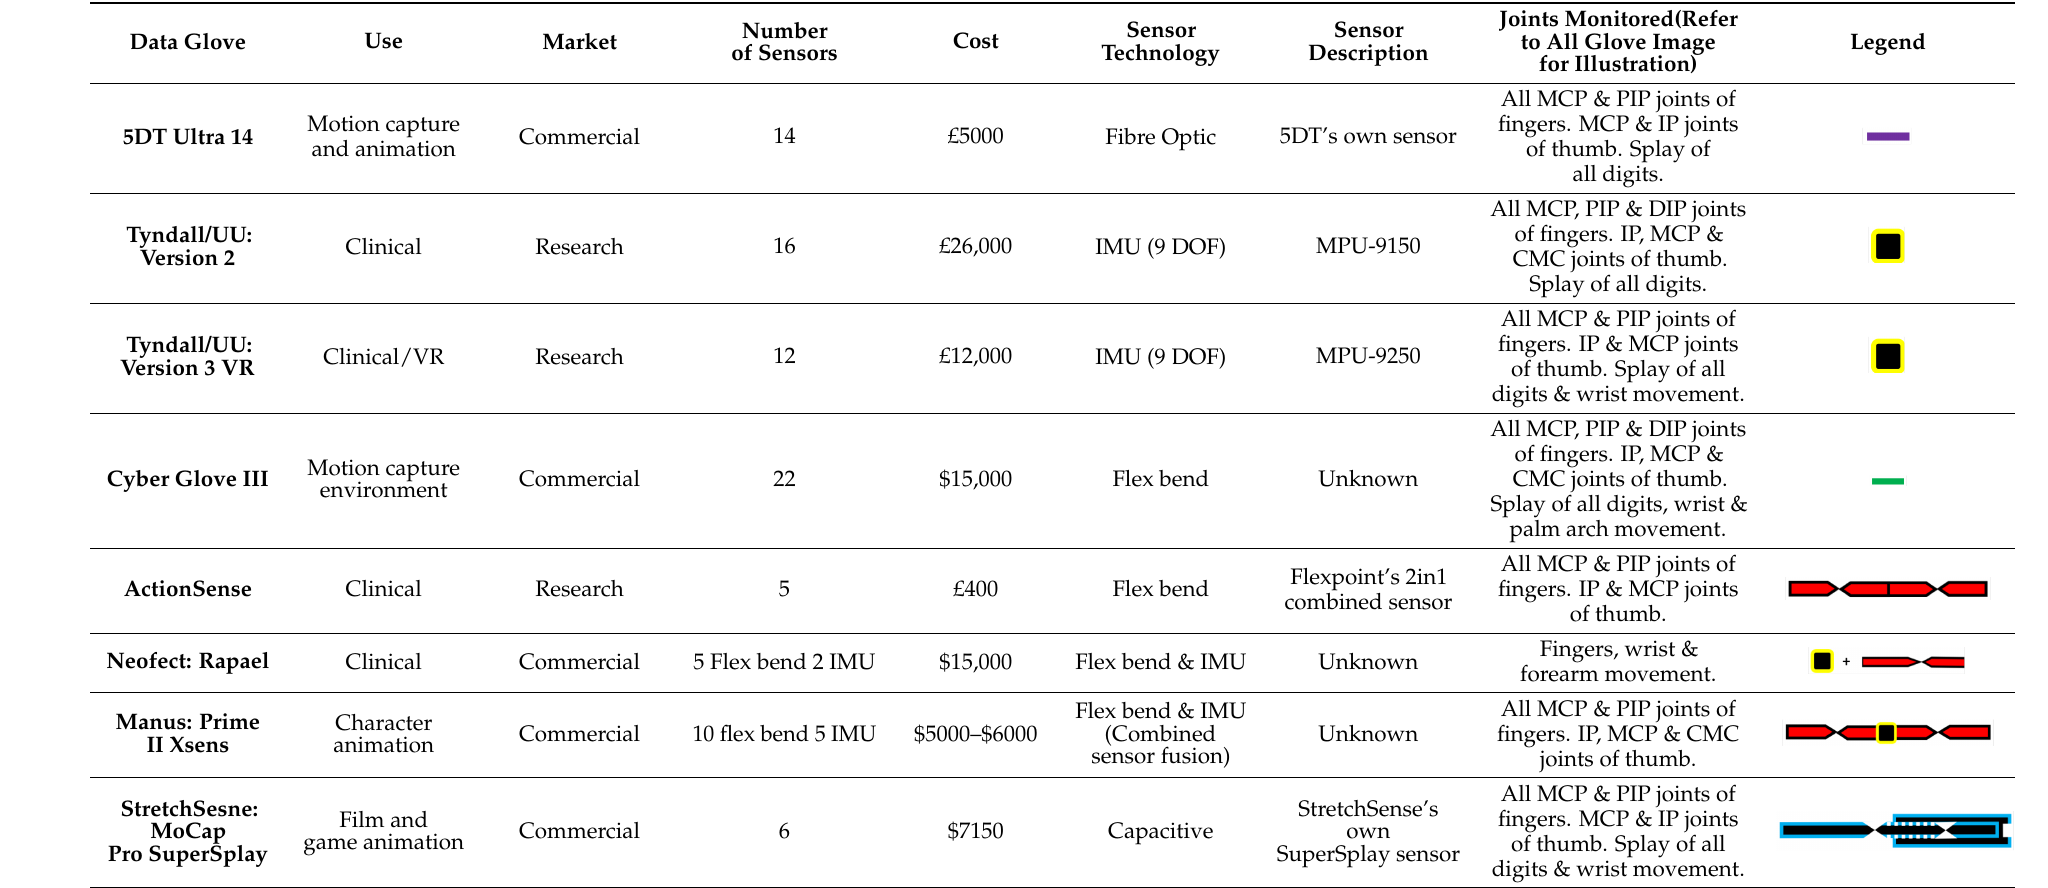
Table 2. Modern commercialized and research smart